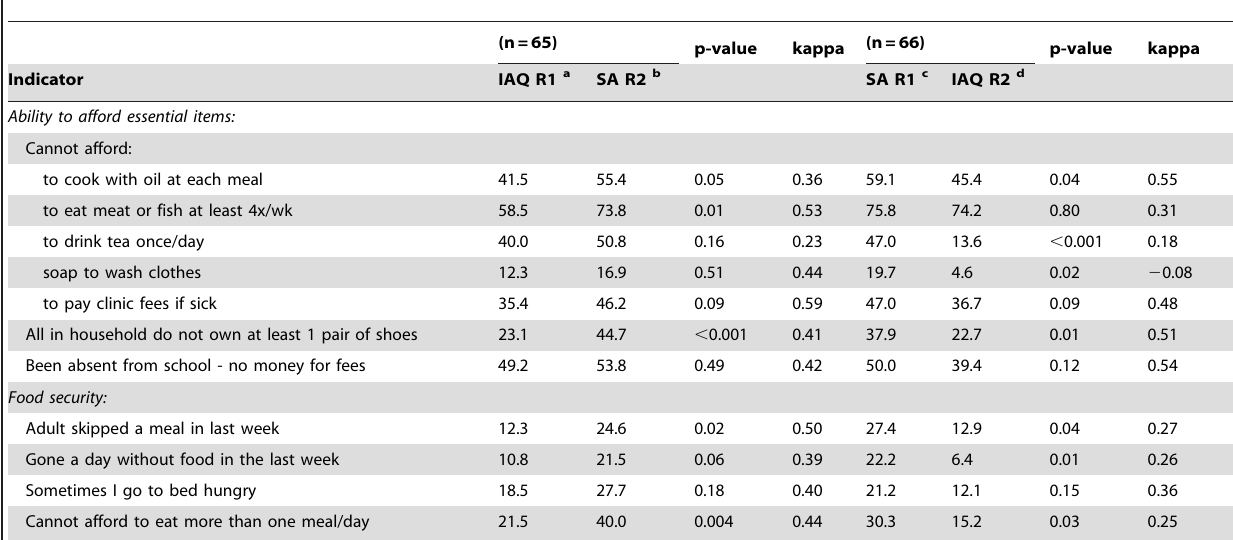
Table 4. Proportion of respondents reporting each socio-economic indicator in each round and the extent of agreement between each round for respondents using IAQ in one round and self-administered in the other.